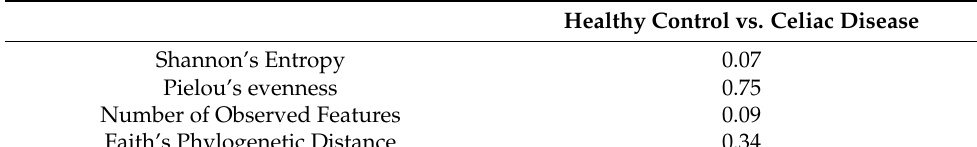
Table 2. Summary of pairwise group comparisons for four alpha diversity indexes. Benjamini and Hochberg corrected p -values ( q -values) for Kruskal–Wallis tests are shown.